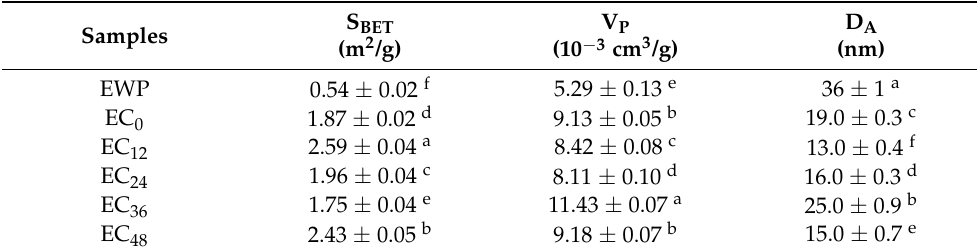
Table 2. Pore parameters of the sample aerogels: BET specific surface area (S BET ), pore volumes (V P ), and average pores diameter (D A ).